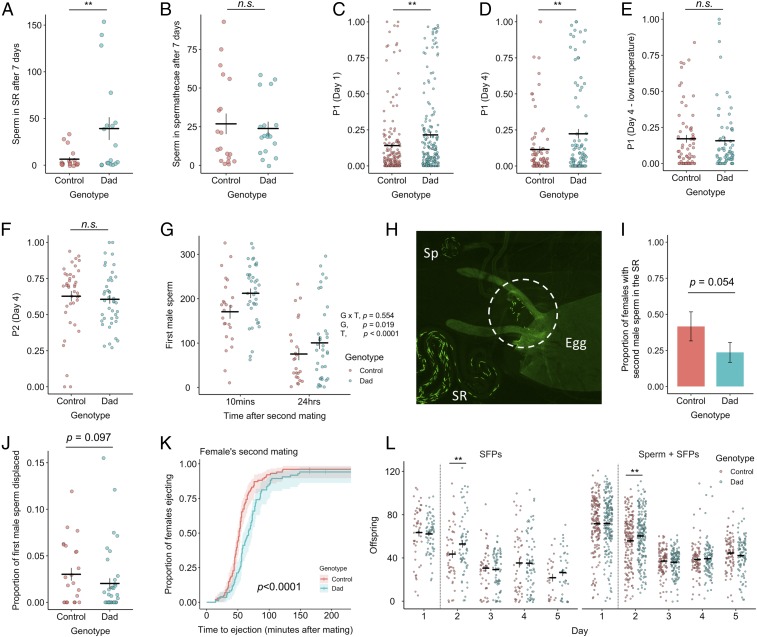
Dad-mated females overretain sperm, have higher first male paternity, and handle a second ejaculate differently. (A) The number of sperm in the seminal receptacle 7 d after singly mating to a Dad or control male. nDad = 18, ncontrol = 19. (B) As in A, but the total across both spermathecae. nDad = 18, ncontrol = 19. (C) First male paternity share when a female first mates to a Dad or control male and then a standardized competitor 24 h later. Offspring collected over the 24 h following remating. nDad = 190, ncontrol = 173. (D) As in C, but offspring collected in a 24-h period 4 d after the female remated. nDad = 92, ncontrol = 81. (E) As in D, but conducted at 20 °C to block Dad overexpression. nDad = 69, ncontrol = 67. (F) Second male paternity share (P2) when a female first mated to a standardized competitor male and then a Dad or control male 24 h later. Offspring collected in a 24-h period 4 d after remating. nDad = 43, ncontrol = 41. (G) Dad or control sperm across all regions of the female reproductive tract 10 min or 24 h after remating to a standardized competitor. At 10 min: nDad = 38, ncontrol = 24; at 24 h: nDad = 38, ncontrol = 24. The P values associated with genotype G, timepoint T, and their interaction G x T in predicting sperm numbers are provided. (H) A female dissected at 5 h after singly mating to a control male. Released sperm in the uterus are circled. SR, seminal receptacle; Sp, spermathecae. (I) Proportion of females where second male sperm has entered into the storage organs 10 min after the start of mating. Females mated to a Dad or control male 24 h previously. nDad = 38, ncontrol = 24. (J) As in I, but the proportion of the total first male sperm within the female reproductive tract that is found outside of the storage organs. nDad = 38, ncontrol = 24. (K) Latency to ejaculate ejection after previously Dad- or control-mated females remate with a standardized competitor. nDad = 85, ncontrol = 101. Confidence interval is 95%. (L) Daily offspring production by Dad- and control-mated females that secondarily mate to either a male transferring seminal fluid but no sperm or a normal second ejaculate. The dashed line gives the point at which the female remates. SFPs: nDad = 66, ncontrol = 48; SFPs + sperm: nDad = 193, ncontrol = 179. In A–G, I, J, and L, horizontal bars represent the mean, with vertical bars representing ±1 SE of the mean or proportion. Data are plotted with horizontal “jitter.” **P < 0.01. n.s., not significantly different. n.s. values between 0.05 and 0.1 are provided.